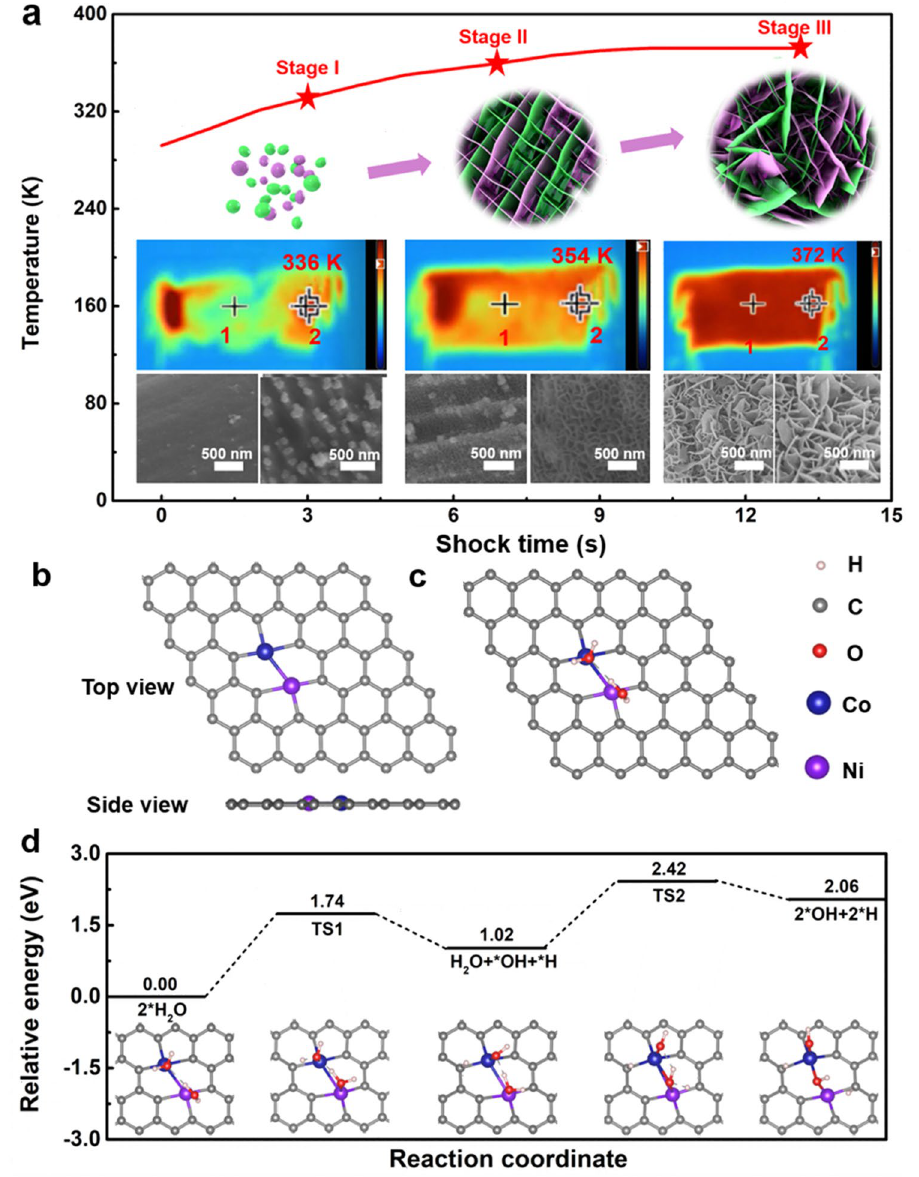
Fig. 3 a Thermal images and SEM images at different markers (middle 1 and edge 2) under thermal shock (illustration 3, 7, and 13 s). b Struc- tures of NiCo/graphene. c Adsorption structure of H 2 O on NiCo/graphene surface. d Energy profile for the decomposition of H 2 O, where TS1 and TS2 are the transition